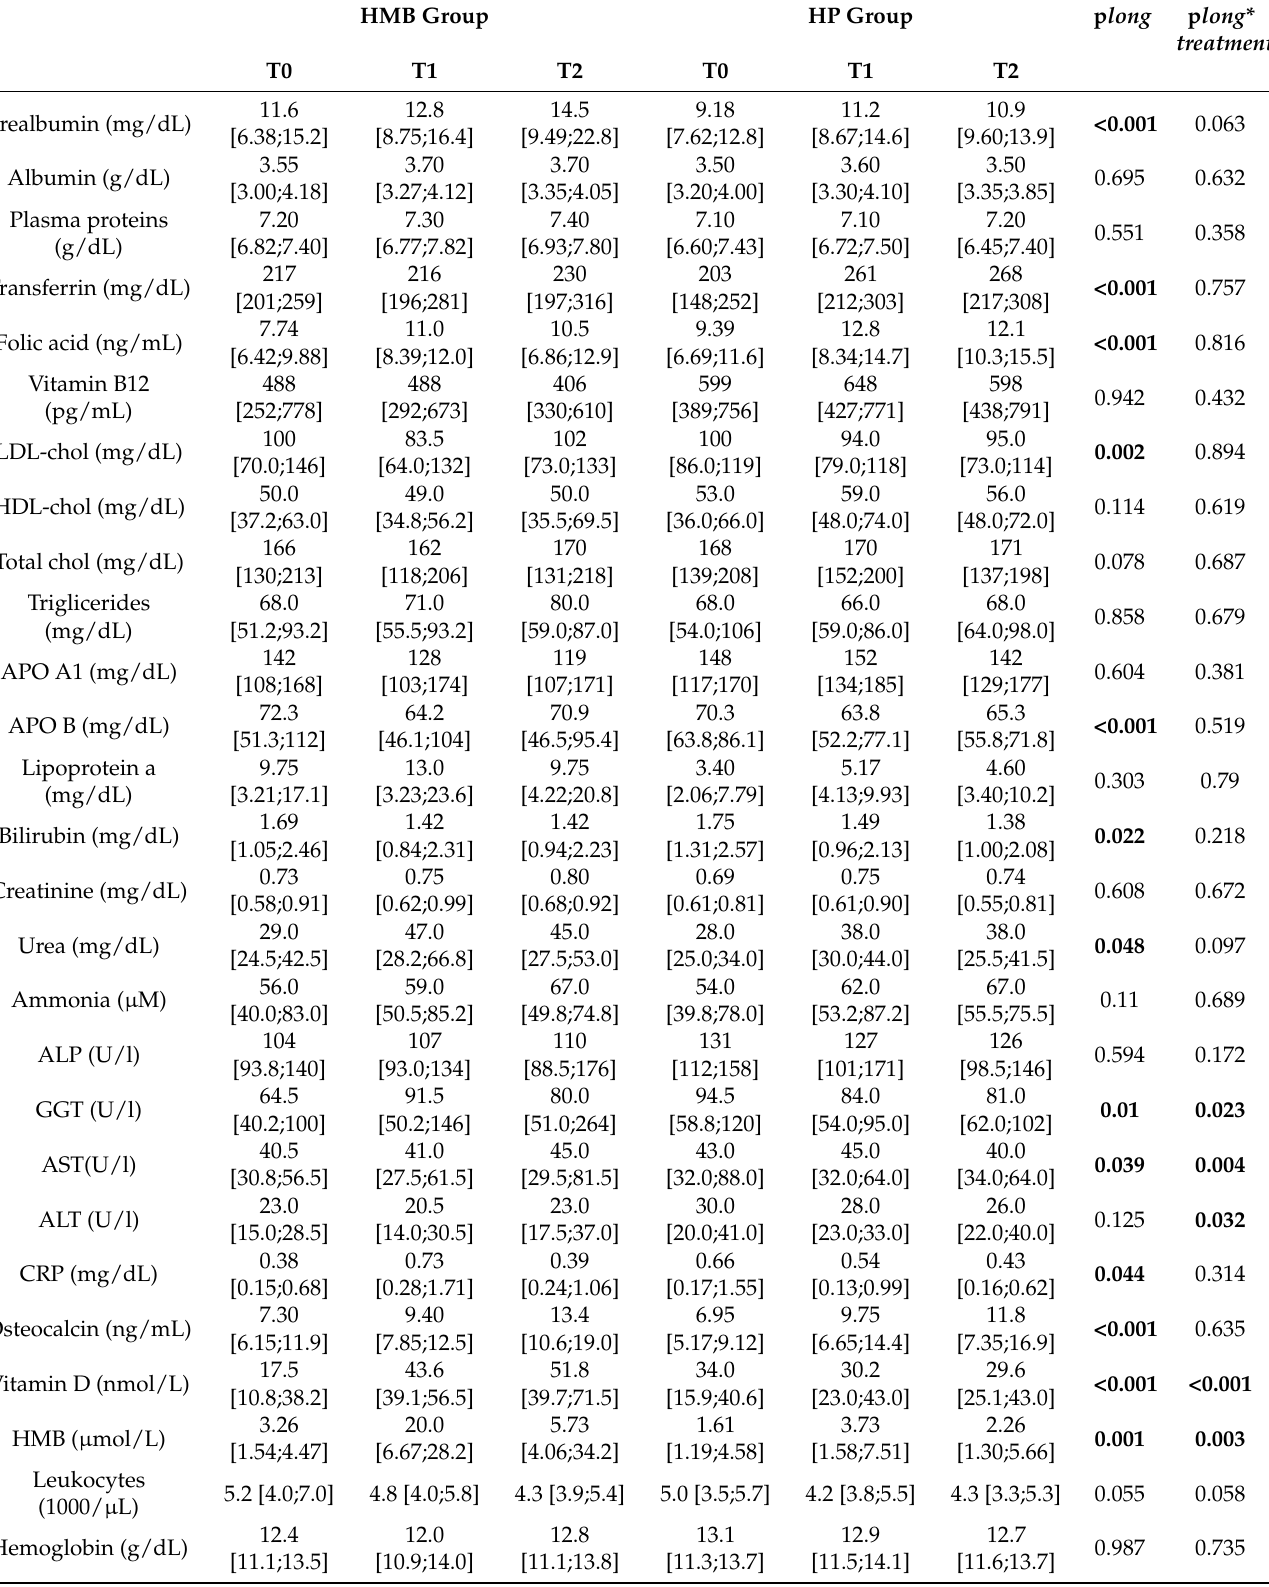
Table 3. Longitudinal changes in plasma